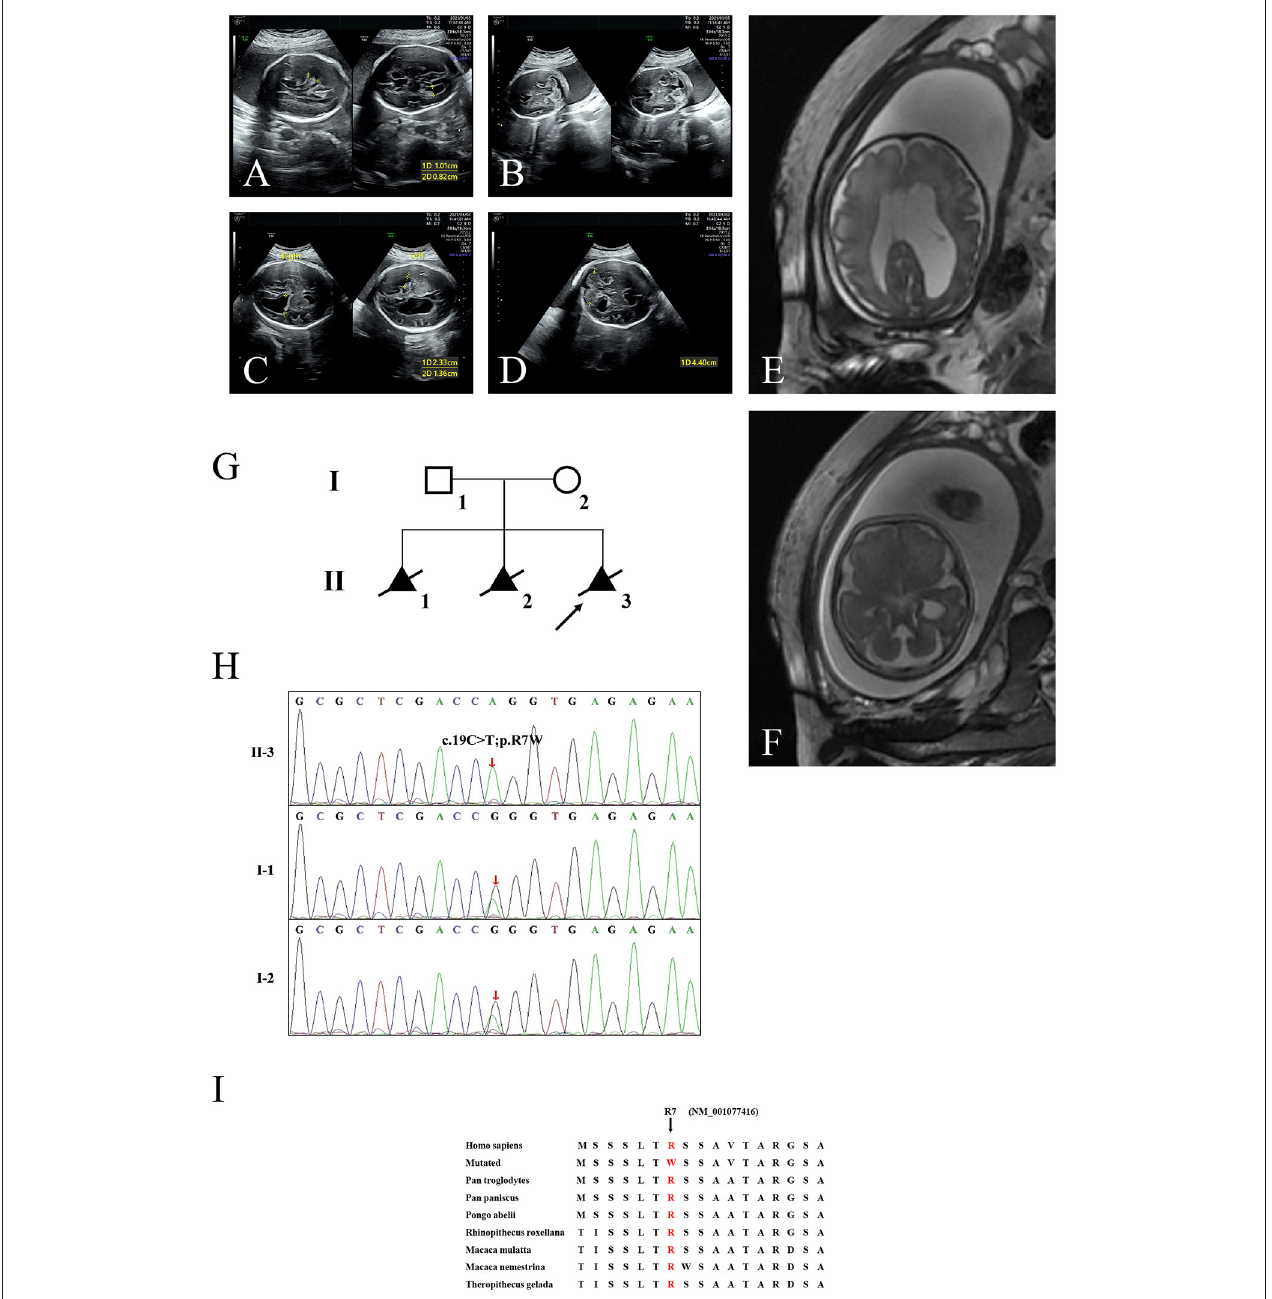
FIGURE 1 | The clinic and sequencing data of this JBTS/MKS family. Ultrasound images show lateral ventricle (A) and cerebellum in transverse section (B) of the proband (II-3) at 22nd-week gestation. Lateral ventricle (C) and cerebellum (D) ultrasound images at 34th-week gestation. 3D FIESTA shows lateral ventricle (E) and cerebellum in transverse section (F) at 34th-week gestation. (G) The genealogy of this JBTS/MKS family. Squares indicate male family members; circles, female members; triangles, fetus; black symbols, the affected members; white symbols, unaffected members; arrow, proband. (H) Sanger DNA sequencing chromatogram detected a homozygosity mutation (c.19C > T;p.R7W) of TMEM231 gene in the proband. (I) Alignment of multiple TMEM231 protein sequences across species. Letters in red show the R7 site (NM_001077416) are evolutionarily conserved. FIESTA, Fast Imaging Employing Steady-state